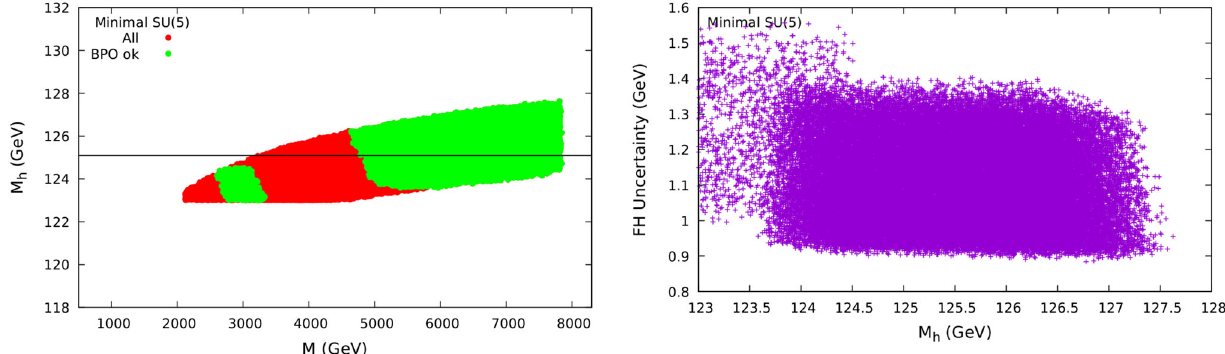
Fig. 2 Scatter plots for the minimal N = 1 SU ( 5 ) model. Left: the lightest Higgs mass, M h , as a function of M . The B -physics constraints allow (mostly) higher scale points (with green color). Right: the theoretical uncertainty of the light Higgs mass